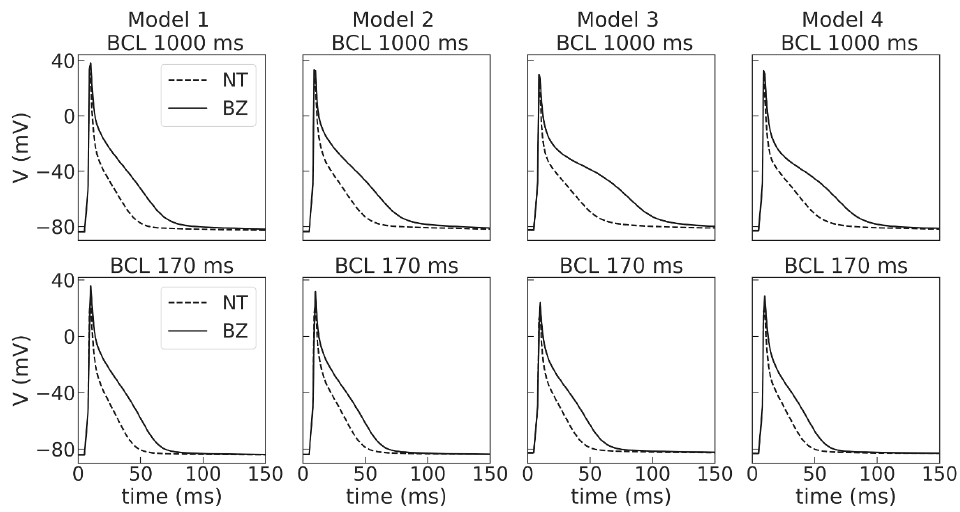
Figure A4. Action potential at BCLs of 1000 ms (upper panels) and 170 ms (lower panels) in the four cellular models in normal tissue (NT, dashed line) and in the border zone (BZ, solid line) of post-infarction scar.